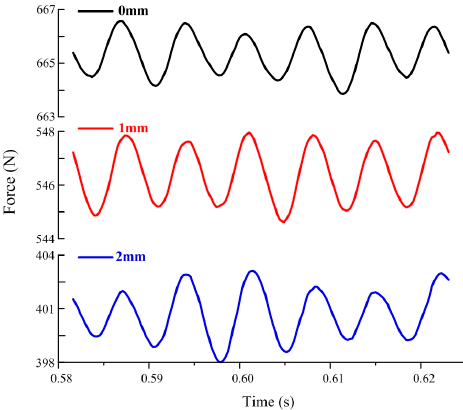
Figure 12. Time revolution of radial force on the blade suction side for different tip clearances.